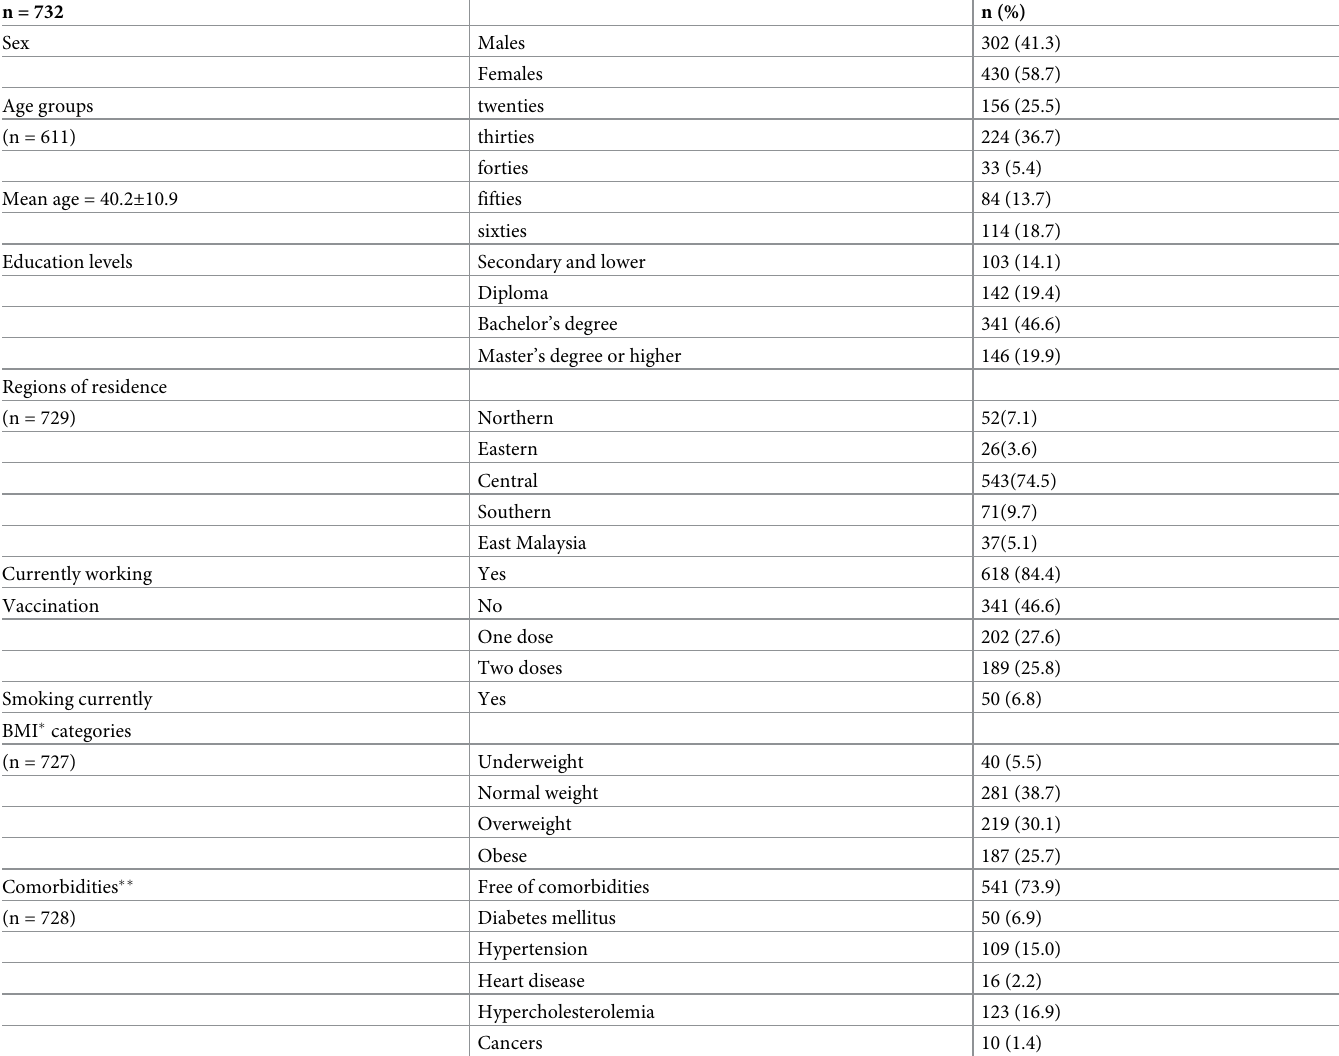
Table 1. Socio-demographic characteristics, Body Mass Index (BMI), vaccination status and medical history of